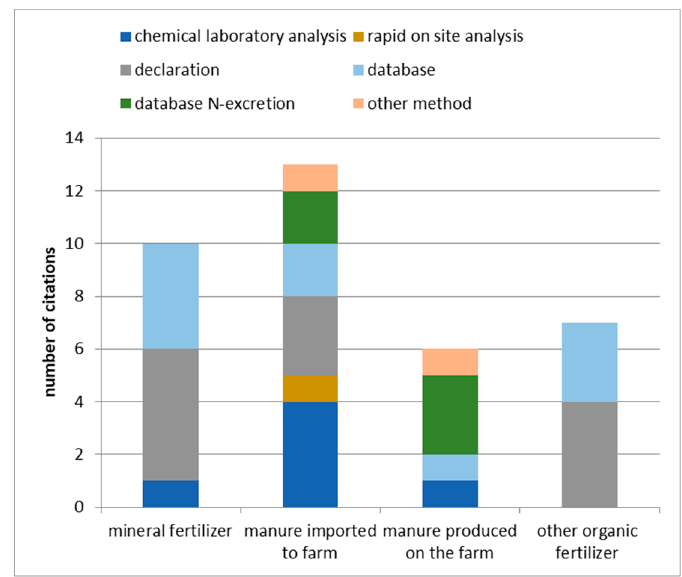
Figure 5. Qualitative determination of elements of nitrogen inflows of soil surface budgets; multiple answers are possible (Source: expert survey results).